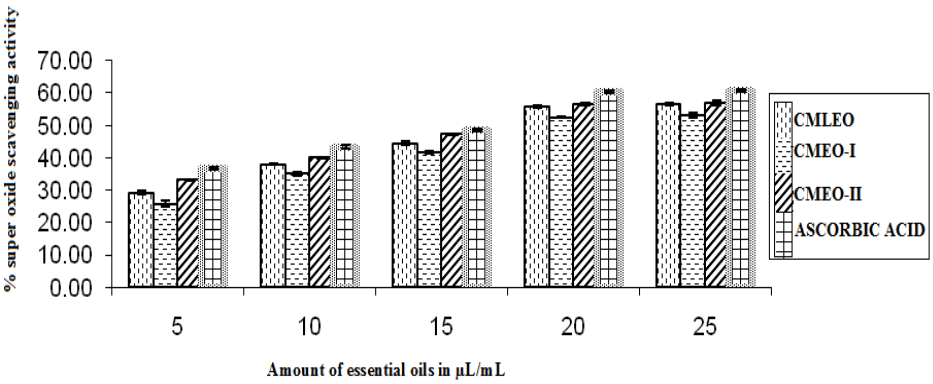
Figure 4. Super oxide scavenging activity.